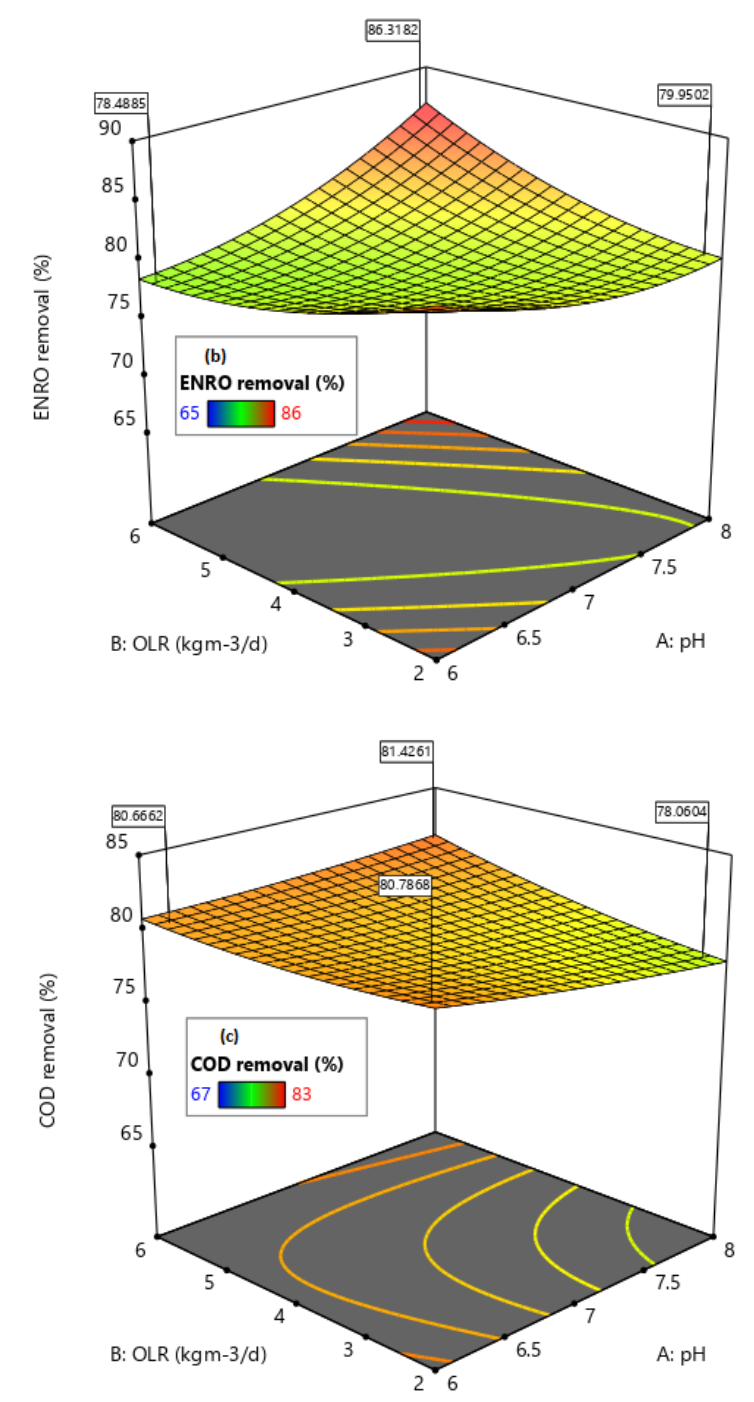
Figure 7. Response 3D plot of pH and OLR effect at constant antibiotic concentration on ( a ) CIP, ( b ) ENRO, and ( c ) COD % removal.